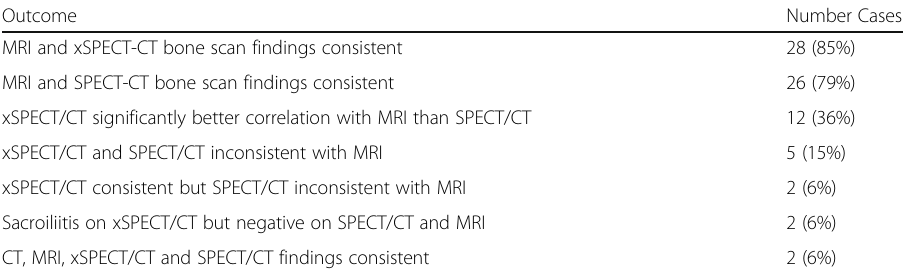
Table 2 Correlation between bone scan and MRI findings Outcome Number